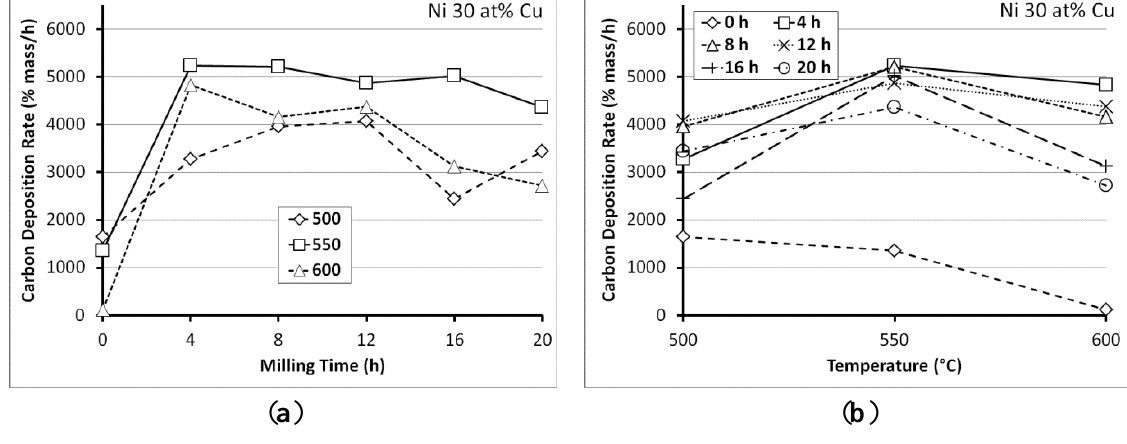
Figure 6. Carbon deposition rates catalyzed by Ni 30 at% Cu milled for ( a ) varying durations and ( b ) at varying temperatures. Samples “milled” for 0 h are the constituent powders blended in the appropriate ratio with no alloying